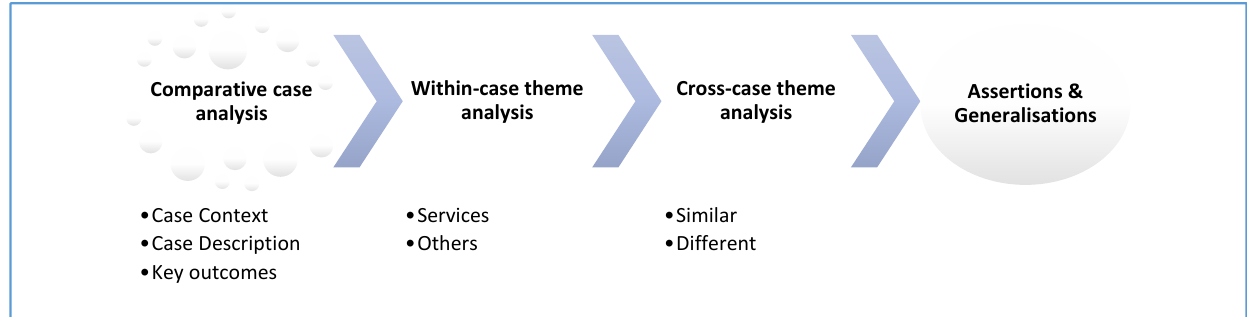
Figure 1. The process in the comparative cases study analysis (adapted from ten Bensel and Sample (2015) [23]).